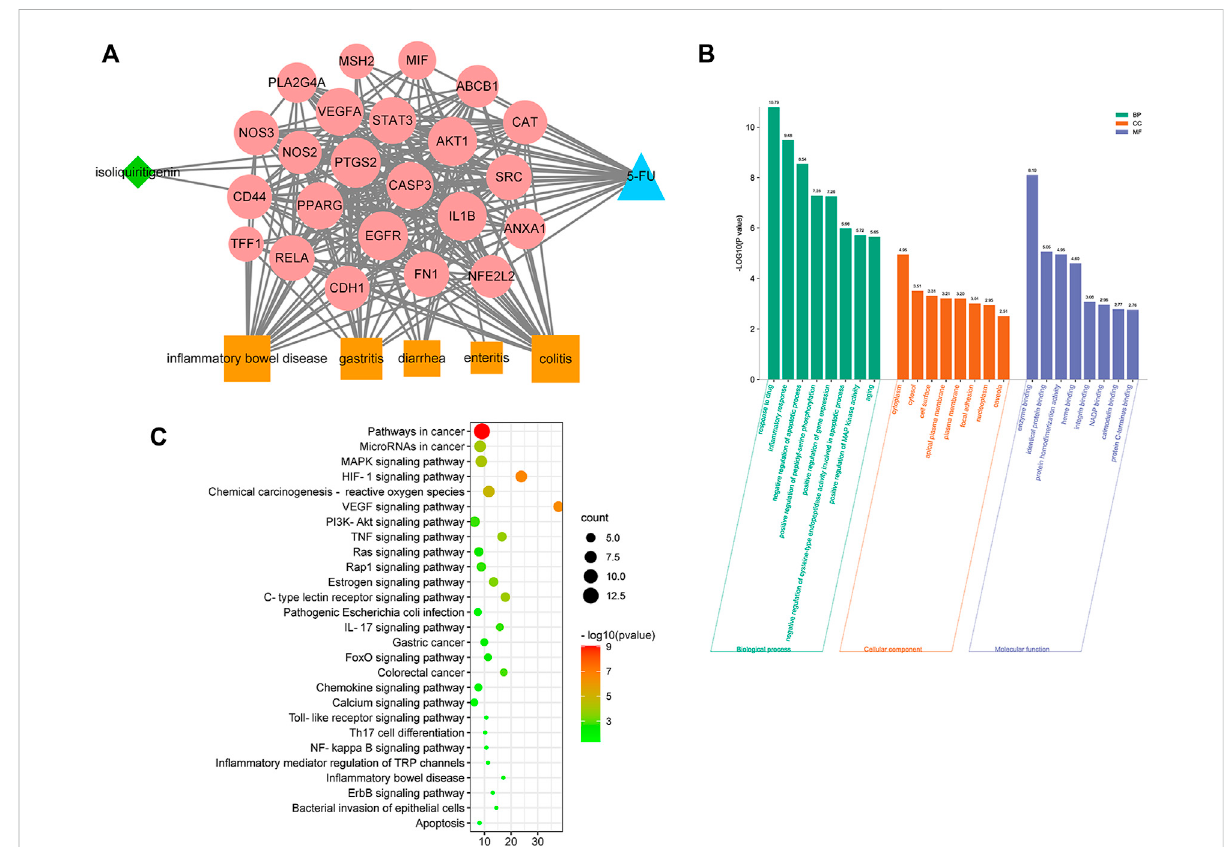
FIGURE 4 Network analysis on the mechanism of ISL against 5-FU-induced gastrointestinal toxicity. (A) Network of ISL, potential targets, 5-FU, and gastrointestinal diseases (ISL-pT-5FU-D Network). The node in blue color is 5-FU, the nodes in red color are potential targets, the nodes in orange color are gastrointestinal diseases, and the node in green color is ISL. (B) KEGG pathway enrichment analysis of potential targets. The pathways related to in fl ammation and gastrointestinal diseases with p values less than 0.05 are shown. (C) GO enrichment analysis of potential targets: cellular components, molecular functions, and biological processes associated with the detoxi fi cation effect of ISL on 5-FU. The top 8 with lower p -value are shown.